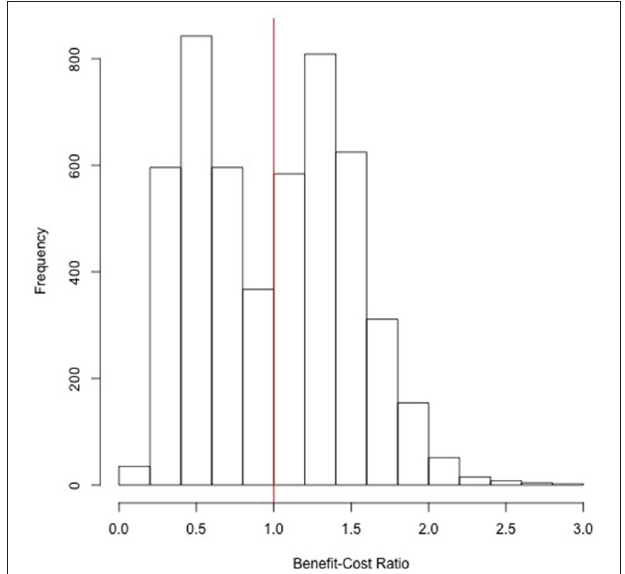
FIGURE 3 | Histogram of benefit–cost ratio (BCR) estimates from the stochastic cost–benefit model based on 5,000 simulations. The vertical red line is at a BCR of 1 over which the investment is considered financially